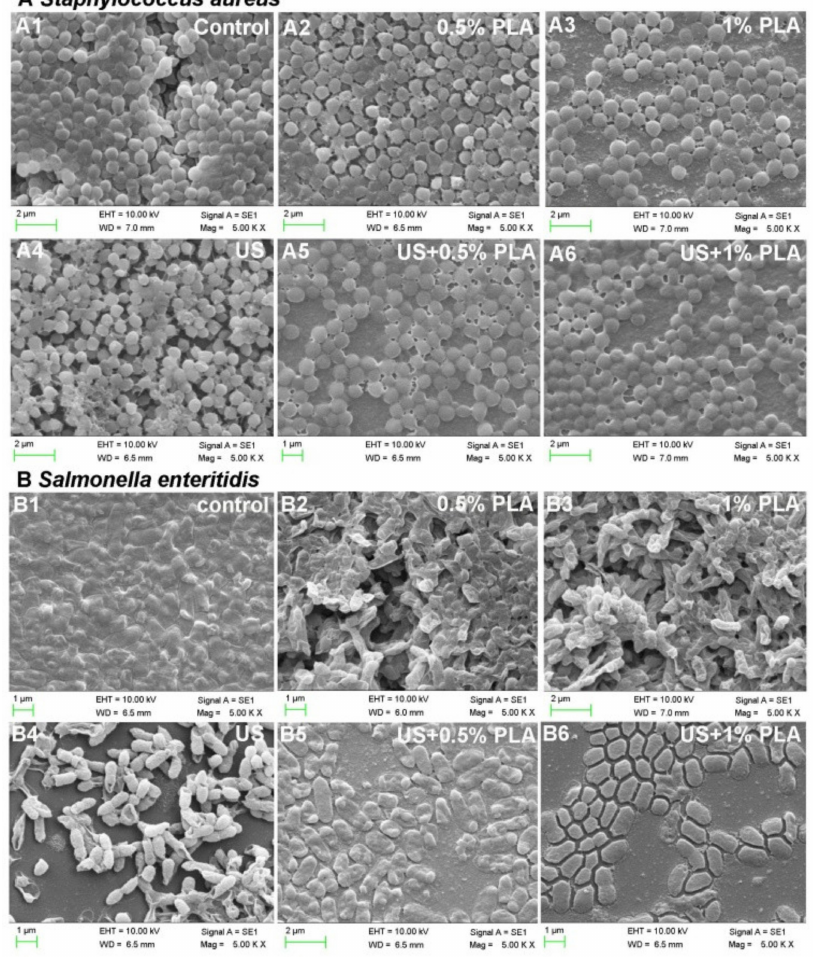
Figure 3. Scanning electron microscopy of S. aureus ( A ) and S. enteritidis ( B ) after the single and combined treatment of US and PLA for 30 min. US, ultrasound; PLA, phenyllactic